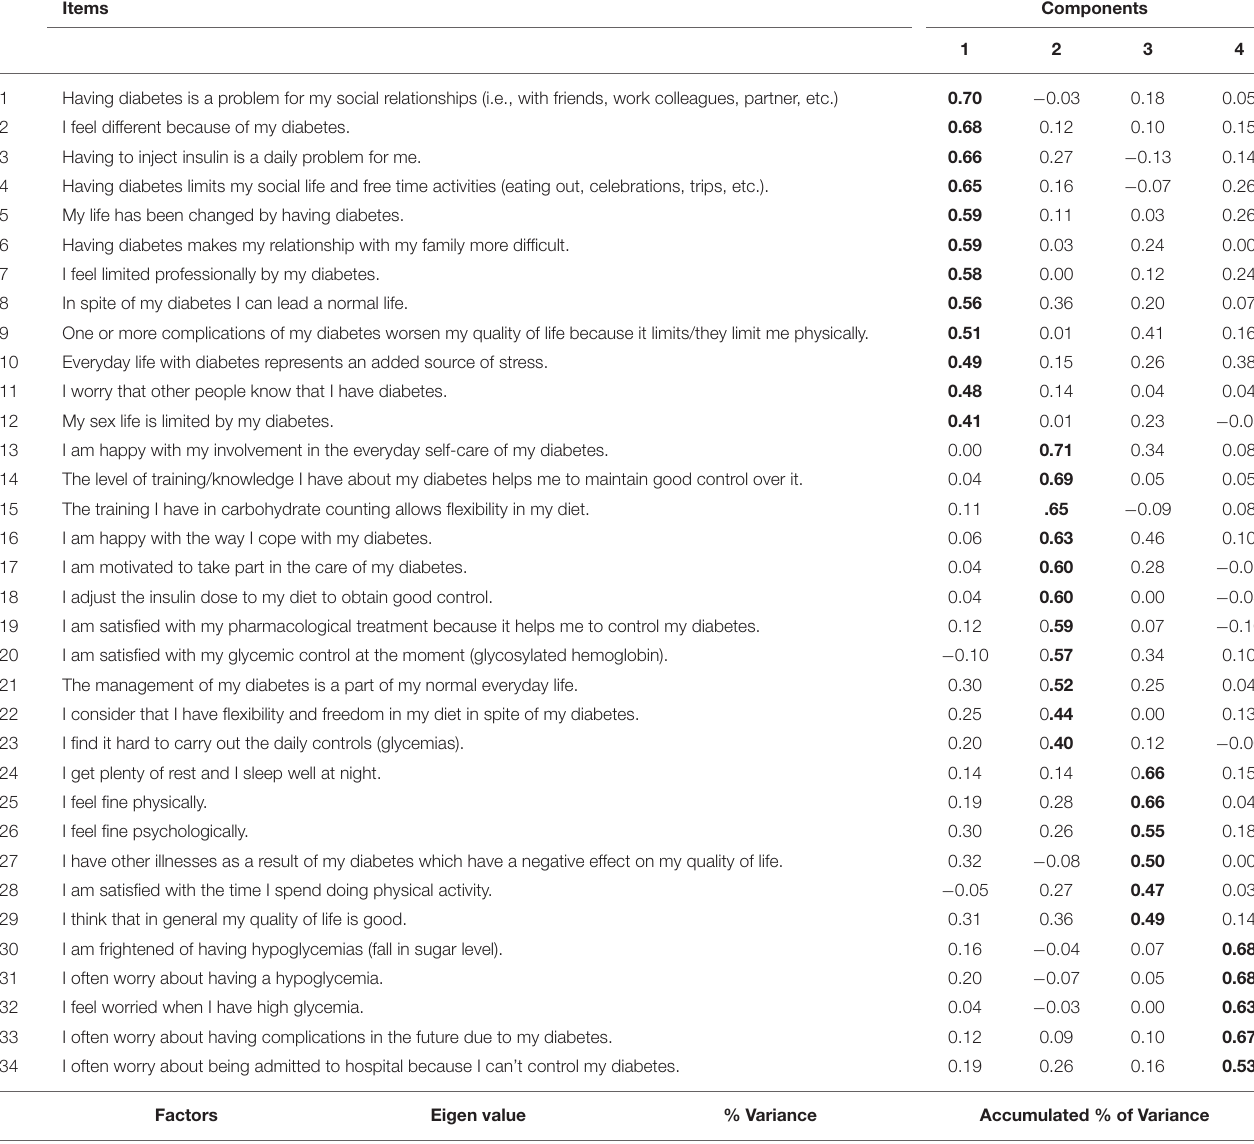
TABLE 3 | Principal Component Analysis with varimax rotation ( N = 578). Items